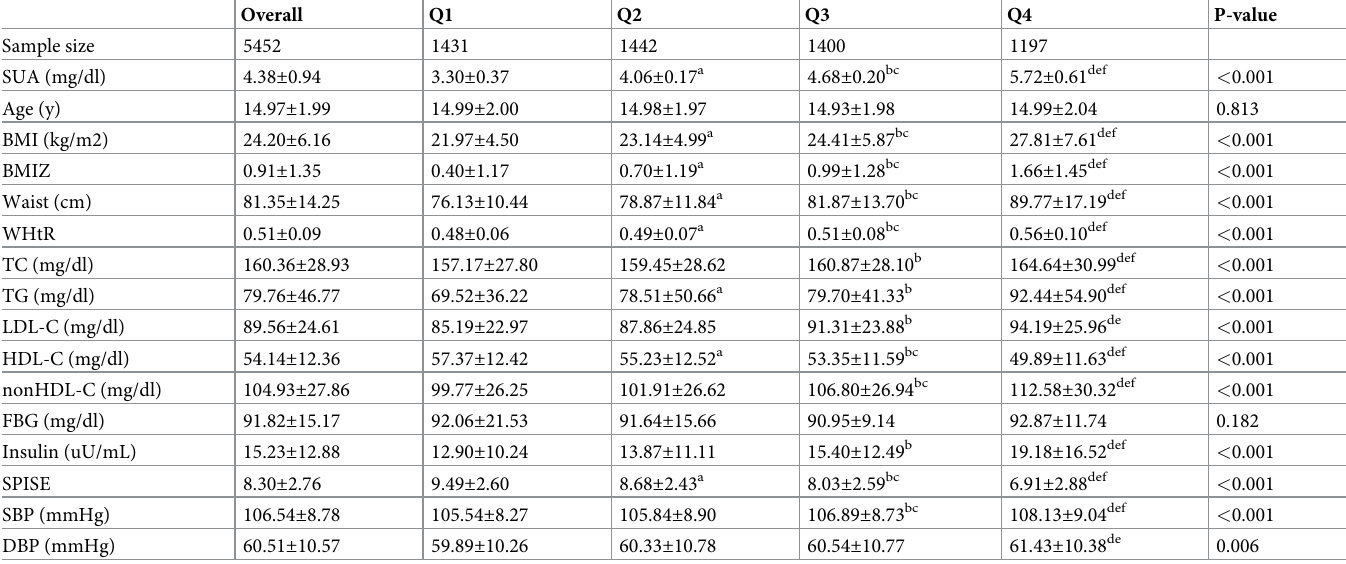
Table 3. Clinical characteristics and cardiometabolic risk factors by quartiles of serum uric acid in